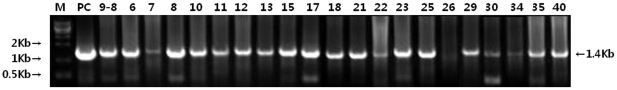
RT-PCR analysis of infected HEp-2 cell lysates.Agarose gel electrophoresis of RT-PCR products was performed to detect G gene. cDNA from cell lysates of RSV A2-infected HEp-2 cells was used as a positive control. Isolate numbers are indicated for each lane. M: size marker, PC: positive control.